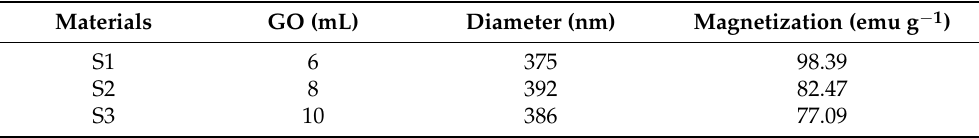
Figure 1. Schematic diagram of the synthesis of chain-typed Fe 3 O 4 @rGO nanoparticles by hydrothermal method in the presence with an applied magnetic field. Table 1. GO addition, sample diameter, and saturation magnetization intensity of samples S1, S2, and S3.